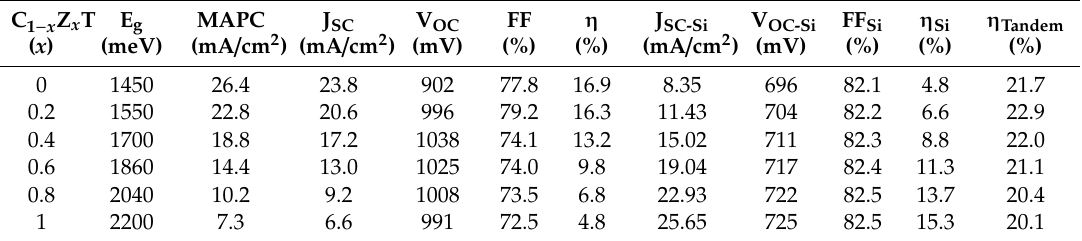
Table 2. Electrical and optical device simulation data for a normal top cell structure with 50 nm CdS ETL, and the corresponding IBC Si rear and tandem cell results as a function of the Zn content in C 1 − x Z x T. Series and shunt resistances are used as 2 and 2 k Ω / cm 2 . Minority carrier lifetime is assumed to be 5 ns in top cell absorbers and surface recombination velocity at the ETL / top cell absorber interface is taken as 500 cm /